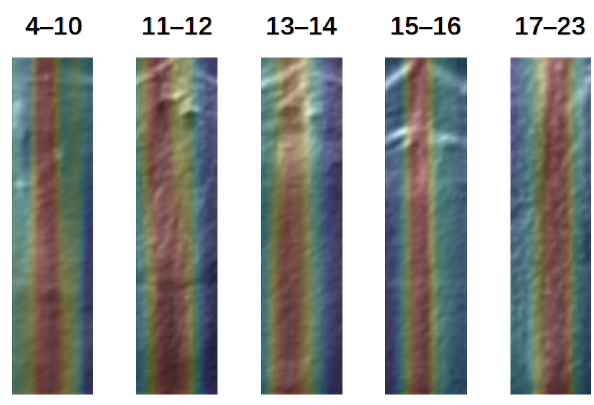
Figure 16. Image region heat maps based on Grad-CAM.